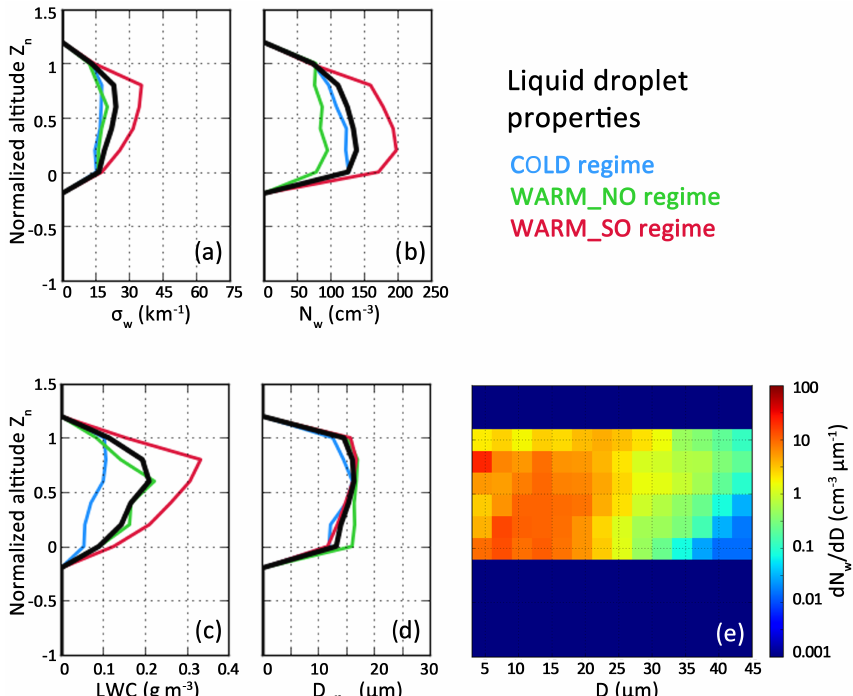
Figure 4. Vertical profiles (expressed in normalized altitude) of liquid droplet properties from FSSP or Nevzorov probe measurements (3– 45µm size range): (a) extinction coefficient, (b) droplet concentration, (c) LWC, (d) effective diameter for the three regimes and averaged over all the campaigns and (e) averaged droplet size distribution for all the